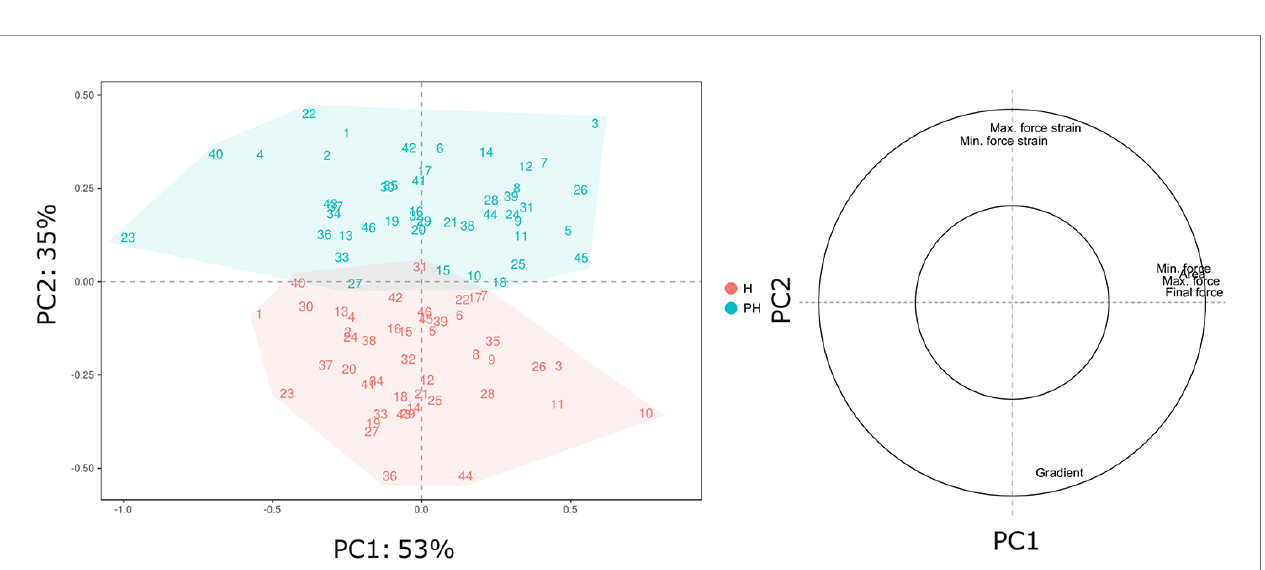
FIGURE 2 | PCA and loading plot of the texture pro fi le of 46 Vaccinium spp. cultivars, assessed by texture analyzer at harvest and after storage. Each point of the PCA plot is the average of 20